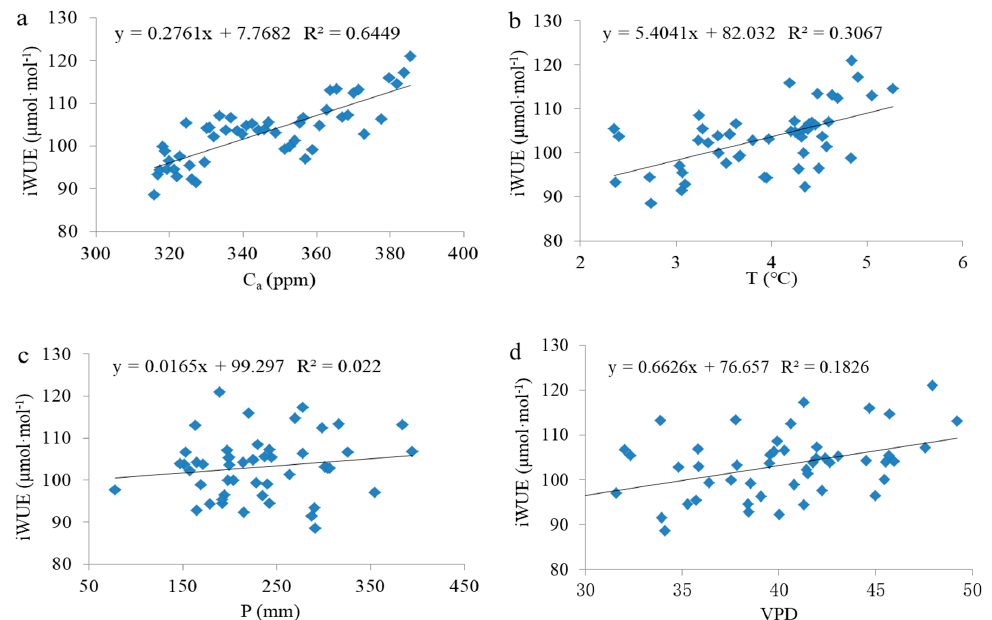
Figure 6. Correlation analysis between the iWUE and main environmental factors (1959 − 2008). ( a ) the correlation between the iWUE and atmospheric CO 2 concentration (C a ); ( b ) the correlation between the iWUE and mean temperature (T); ( c ) the correlation between the iWUE and annual total precipitation (P); ( d ) the correlation between the iWUE and vapor pressure deficit (VPD).